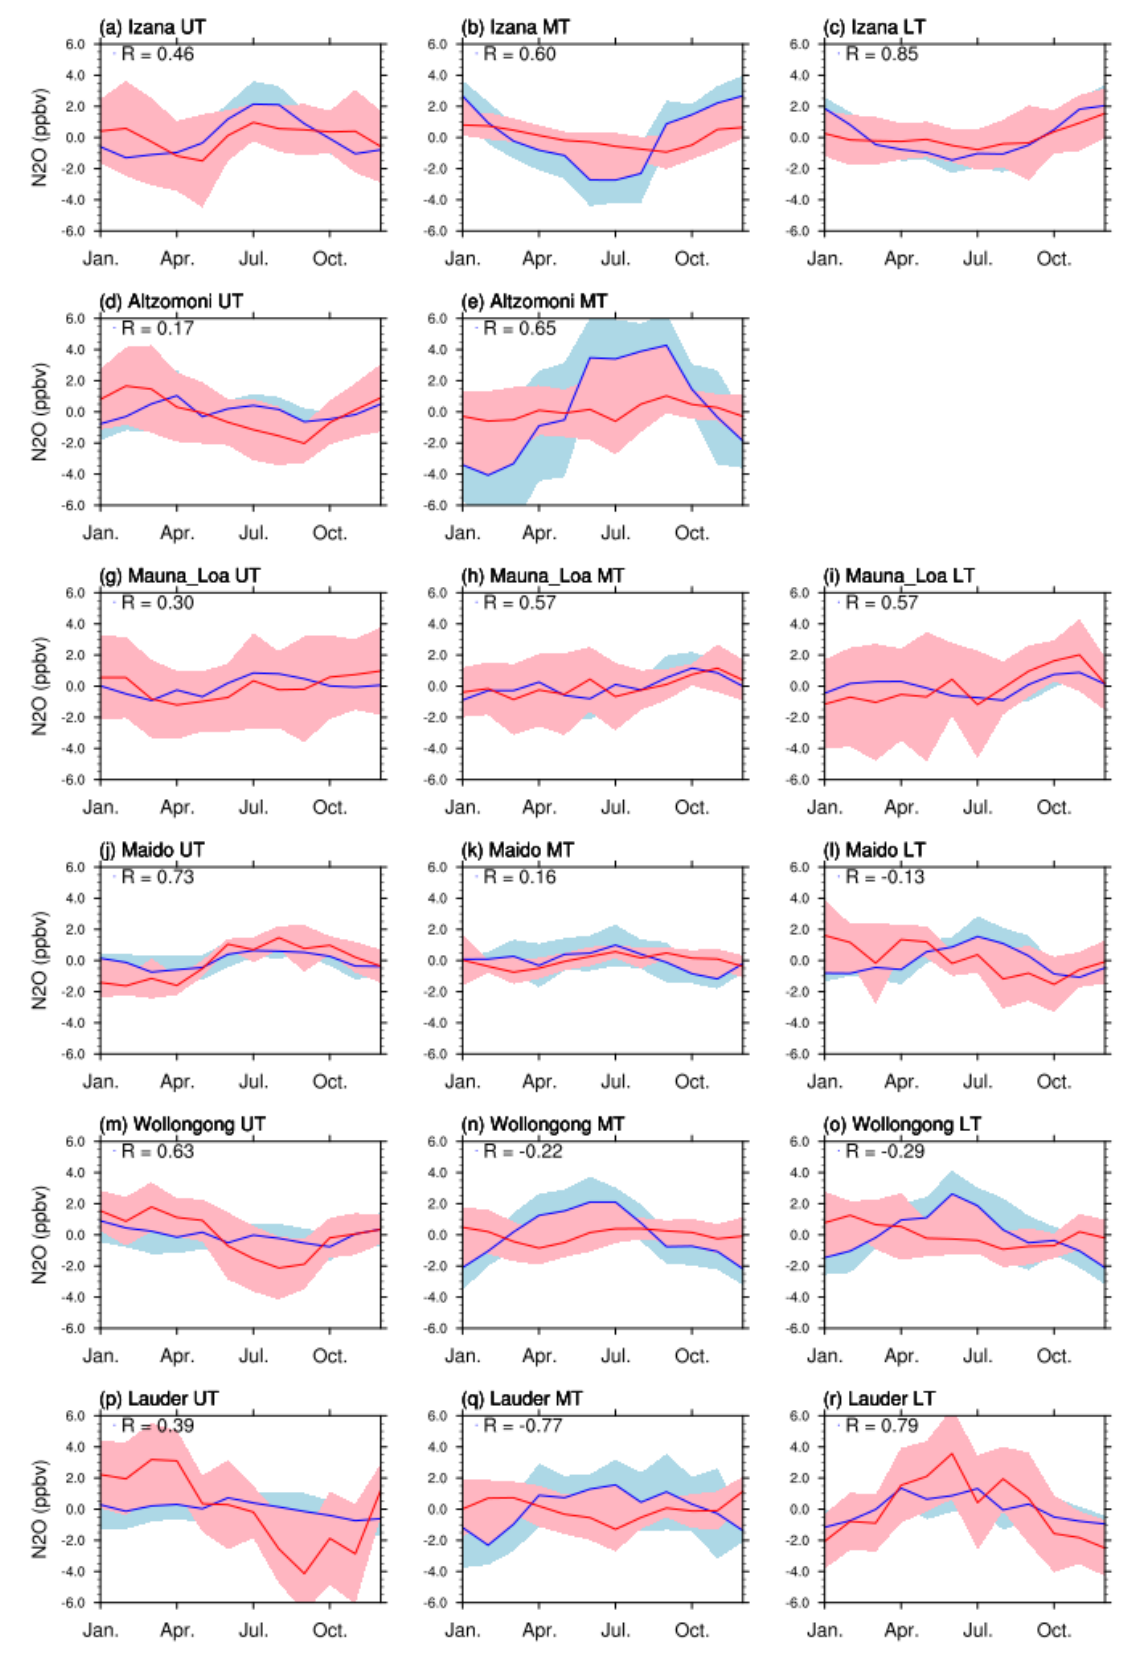
Figure 11. Same as Figure 10 at the 6 tropical and SH stations. There are no data for Altzomoni in the LT (missing panel f) because of the high altitude of the